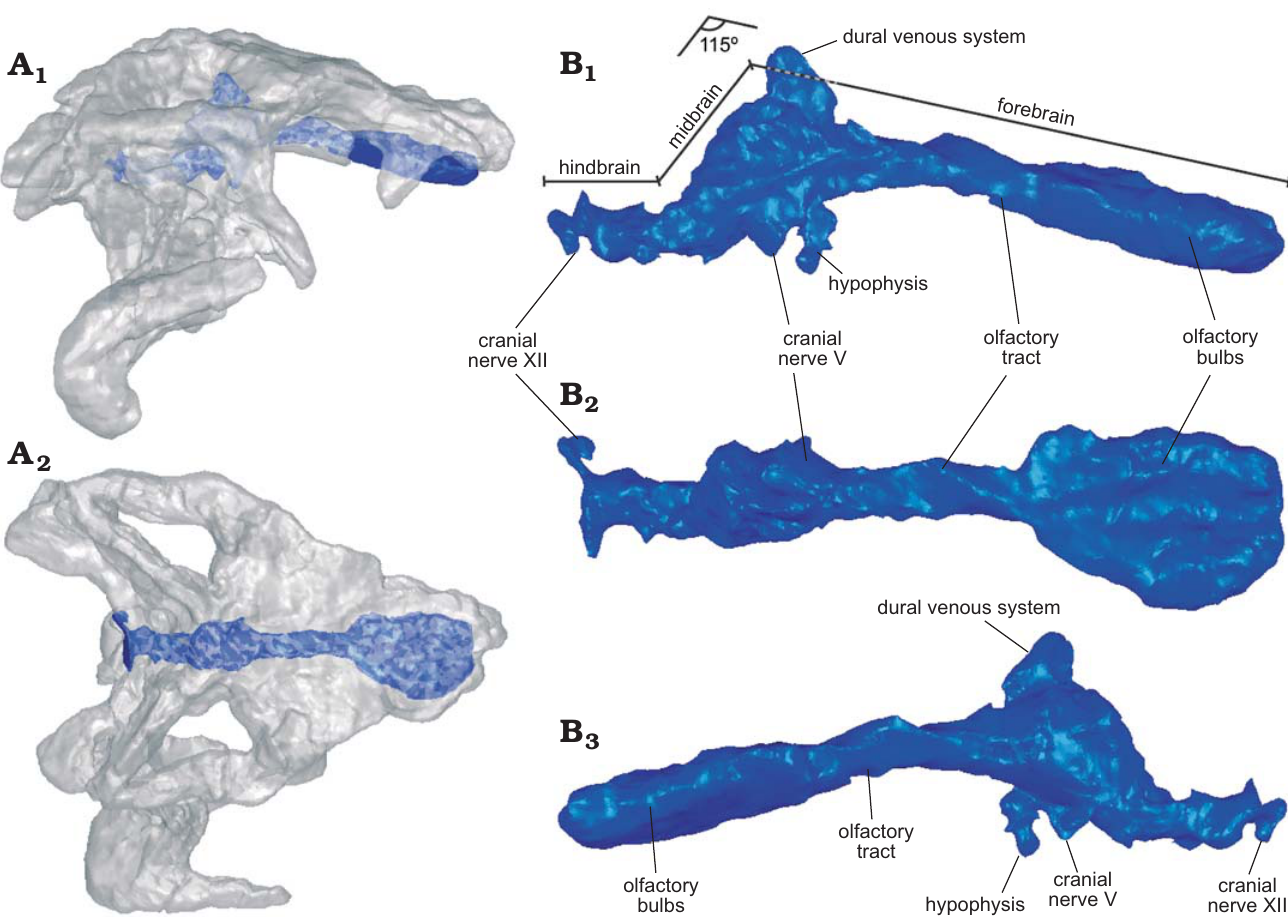
Fig. 19. The pseudosuchian archosaur Prestosuchus chiniquensis Huene, 1938 (UFRGS-PV-0629-T) from the Dinodontosaurus Assemblage Zone, Ladinian, Middle Triassic, Dona Francisca municipality, Rio Grande do Sul State, Brazil. A . Digital model of the braincase in right lateral (A 1 ) and dorsal (A 2 ) views, with endocast (blue) placed in its natural position. B . Digital endocast in right (B 1 ) and left (B 2 ) lateral and dorsal (B 3 ) views. Not to